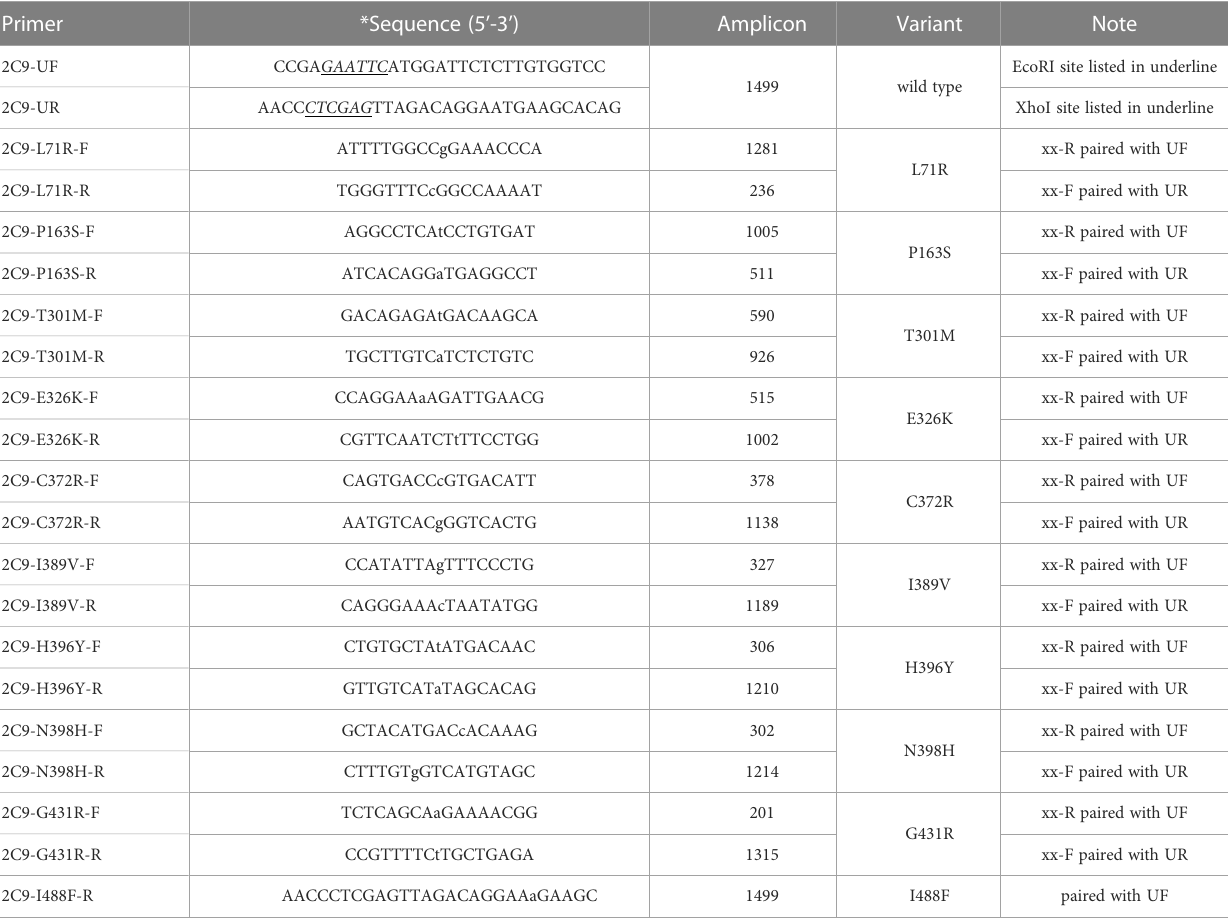
TABLE 2 Primers used for the yeast expression vector